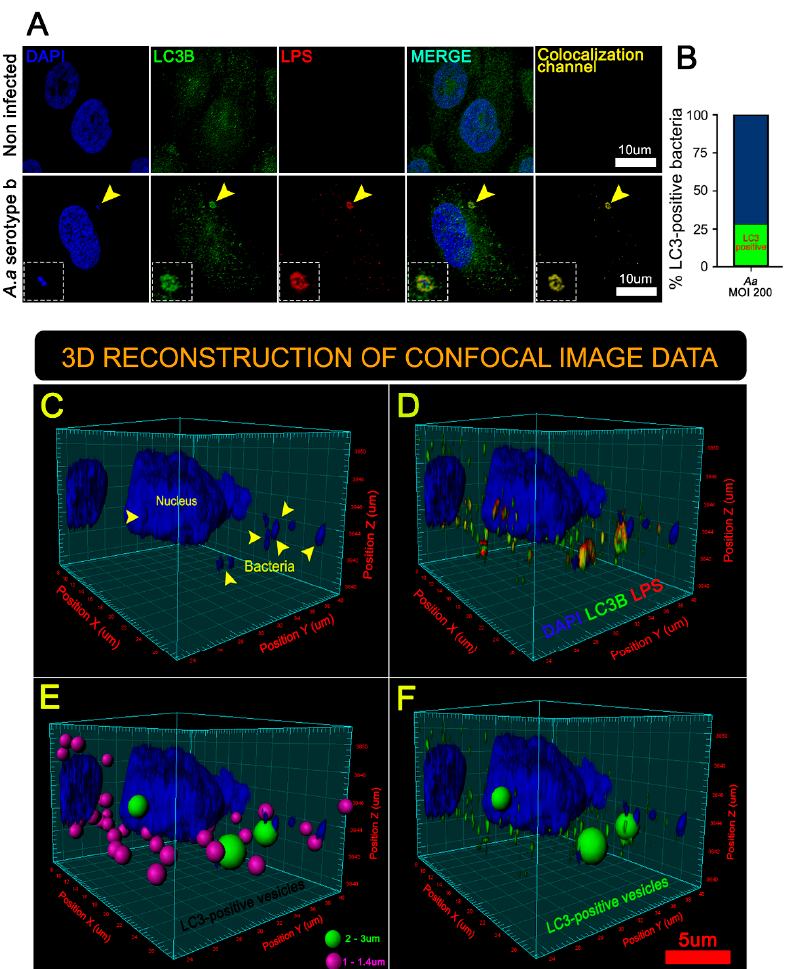
Figure 3. 3-D reconstructions of JEKs infected by A. actinomycetemcomitans revealed two populations of LC3-positive vesicles. ( A ) Immunofluorescence staining visualized by confocal microscopy. Blue: DNA rich structures stained with DAPI; green: LC3B protein labeled with anti-LC3B antibody; red: A.a bacteria labeled with anti-lipopolysaccharides (LPS) antibody; merge: digital overlap of blue, green and red channels; yellow: colocalized voxels from merged file. The yellow arrowhead indicates (area magnified in the insets) a bacteria colocalizing with the host-protein LC3B, scale bar 10 µm. The yellow arrowhead indicates a bacteria colocalizing with the host-protein LC3. ( B ) The graph indicates the fraction of LC3B-positive bacteria (green) related to the total number of intracellular bacteria. A total of ≥ 1000 analyzed cells (15 microscopic fields) of five different experiments. A series of optical sections (z-stacks) acquired by confocal microscopy were combined to generate a 3-D reconstruction. ( C ) 3-D reconstruction showing the data from the DAPI channel. The yellow arrowhead indicates bacterial DNA. ( D ) 3-D reconstruction showing data from blue (DAPI), green (LC3B), and red (LPS) channels. Note the colocalization of green (LC3B) and red (LPS) channels, seen as yellow hue. ( E ) Same as (D) but emphasizing two kinds of LC3B-positive vesicles; in purple: bacteria-free spheres (1–1.4 µ m in diameter), and in green: bacteria-containing spheres (2–3 µ m in diameter). ( F ) Same as (E) but highlighting only the large LC3B-positive vesicles containing bacteria (2–3 µ m in